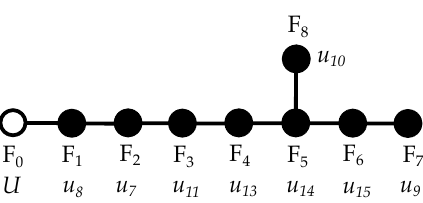
Figure 4 . A(cid:14)ne E 8 Dynkin diagram with labels corresponding to the exceptional sections u i and associated to the Cartan divisors D k that correspond to the simple roots (cid:11) k . The labels u i refer to the exceptional sections of the